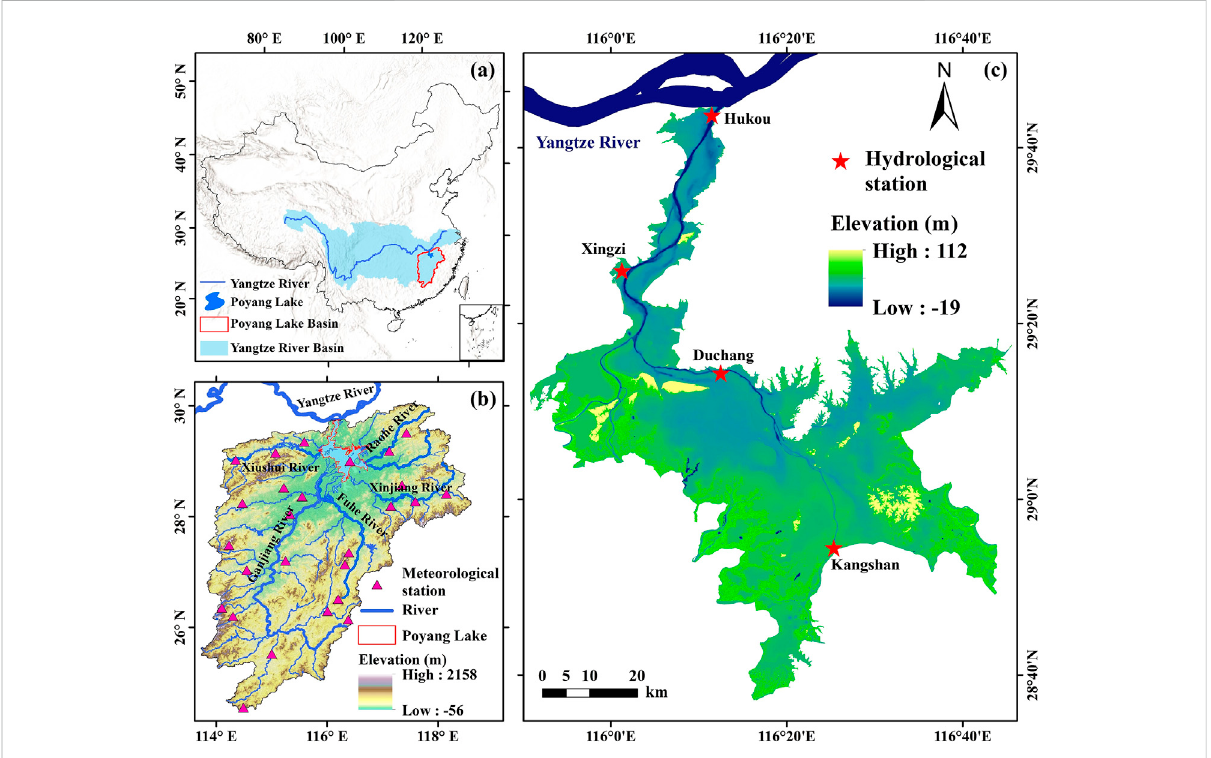
FIGURE 1 Study area with the distributions of meteorological stations in the Poyang Lake basin and hydrological gauging stations in Poyang Lake. (A) Location of the Poyang Lake basin. (B) Location of Poyang Lake and main drainage network in its basin. (C) Spatial distribution characteristics of elevation of Poyang